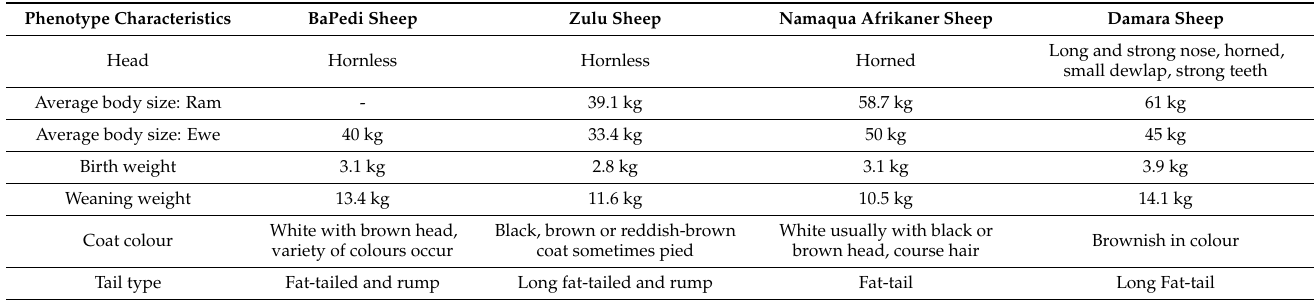
Table 3. Phenotypic characteristics of South African indigenous sheep